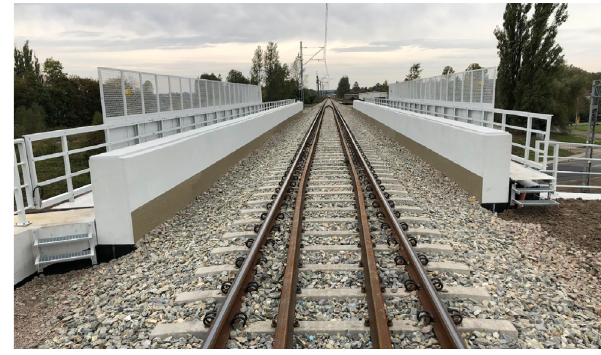
Figure 9: Bridge in Dąbrowa Górnicza after erection. Source: Nowak